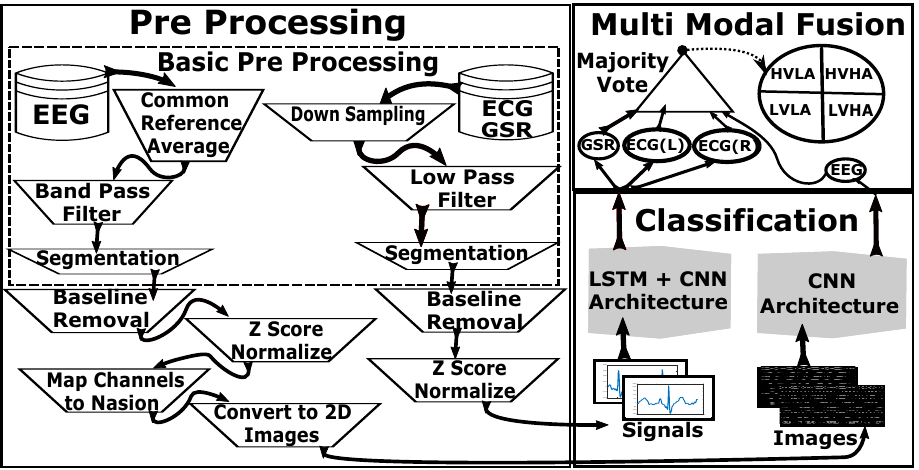
Figure 2. Block Diagram of complete